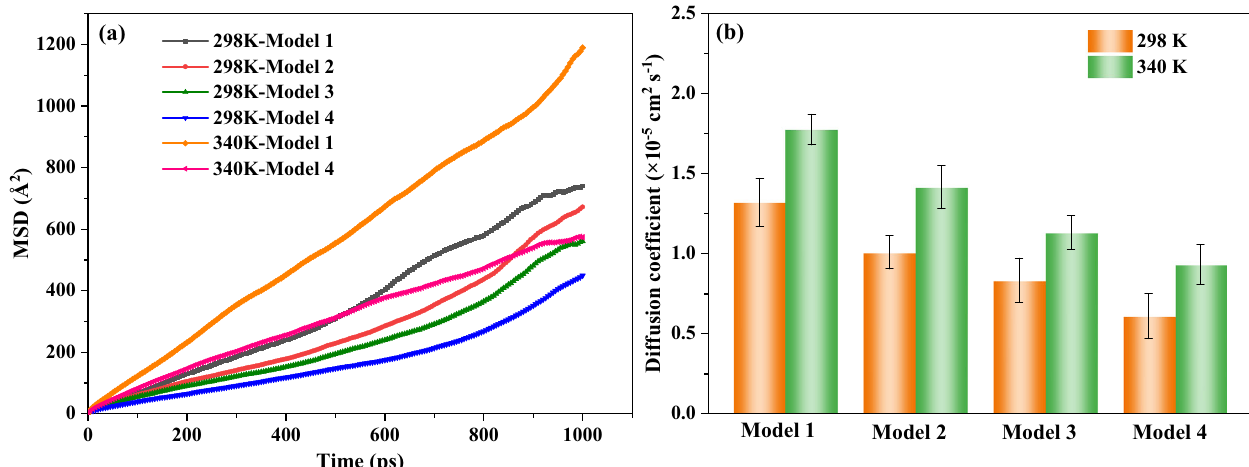
Fig. 9 Diffusion of H 2 O molecules in the unaged and aged nano-silica/PDMS systems. a MSDs and b diffusion coef fi cients. The error bars stand for the standard deviations from fi ve independent